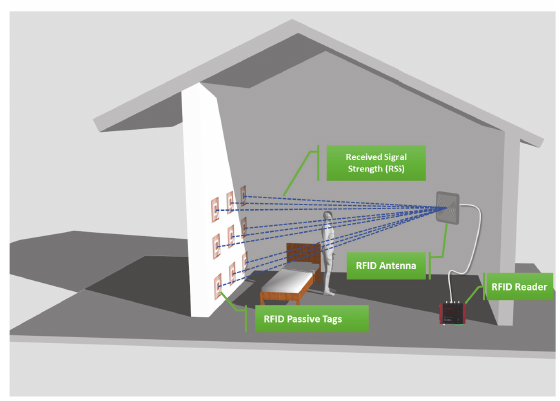
Figure 1: System overview: a user performs different postures in a room setting equipped with an RFID array.